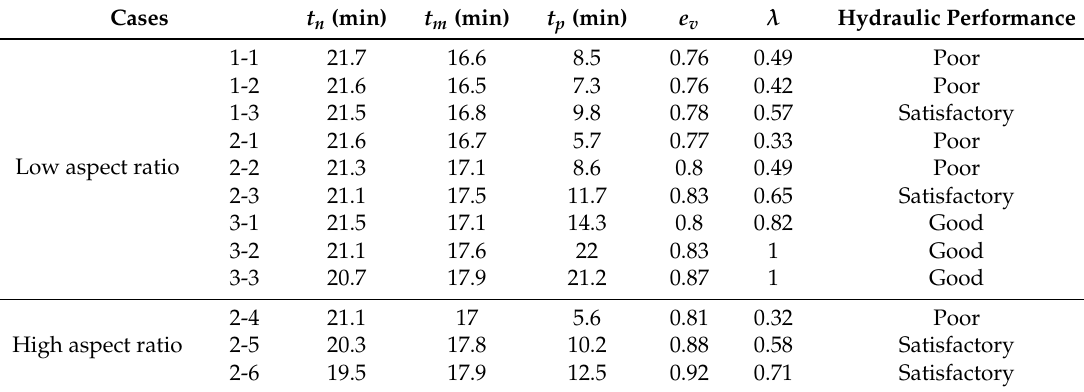
Figure 5. ( a ) Effective volumes and ( b ) hydraulic efficiencies associated with low- and high-density emergent vegetation. Table 6. Nominal retention time, mean residence time, peak time, effective volume, and hydraulic efficiency of cases with low-density emergent vegetation. Table 5. Nominal retention time, mean residence time, peak time, effective volume, and hydraulic efficiency of cases with high-density emergent